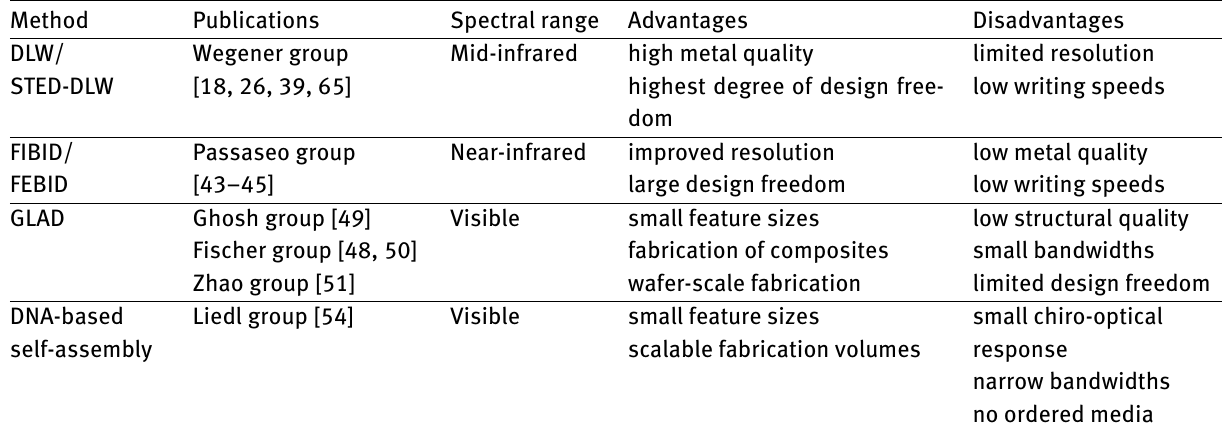
Table 1: Summary of experimental approaches for fabricating metallic helical metamaterials Four methods have been successfully em- ployed to fabricate metallic helical metamaterials for operation at visible and infrared frequencies. The table above lists corresponding publications, as well as strengths and weaknesses of each